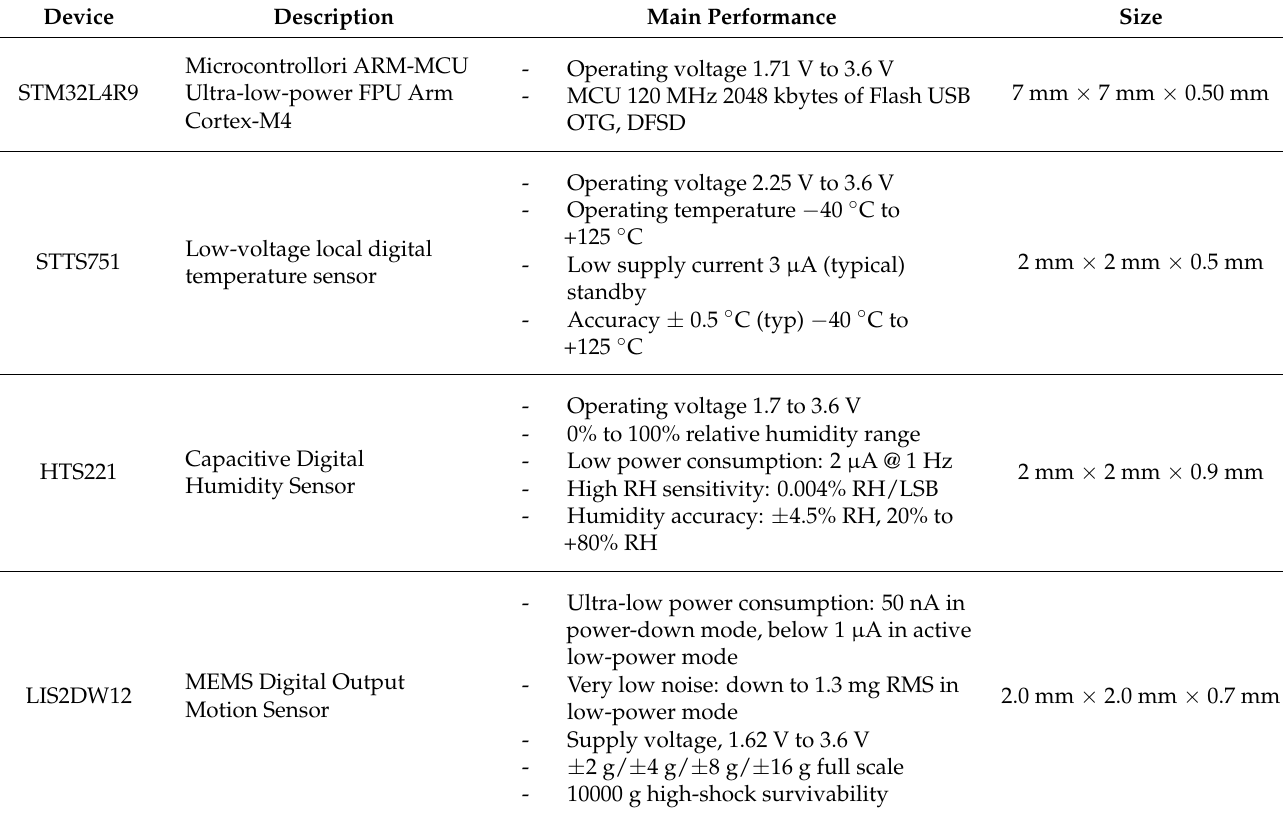
Figure 3. Board used for the monitoring of the painting. Table 2. Characteristic of the sensors.